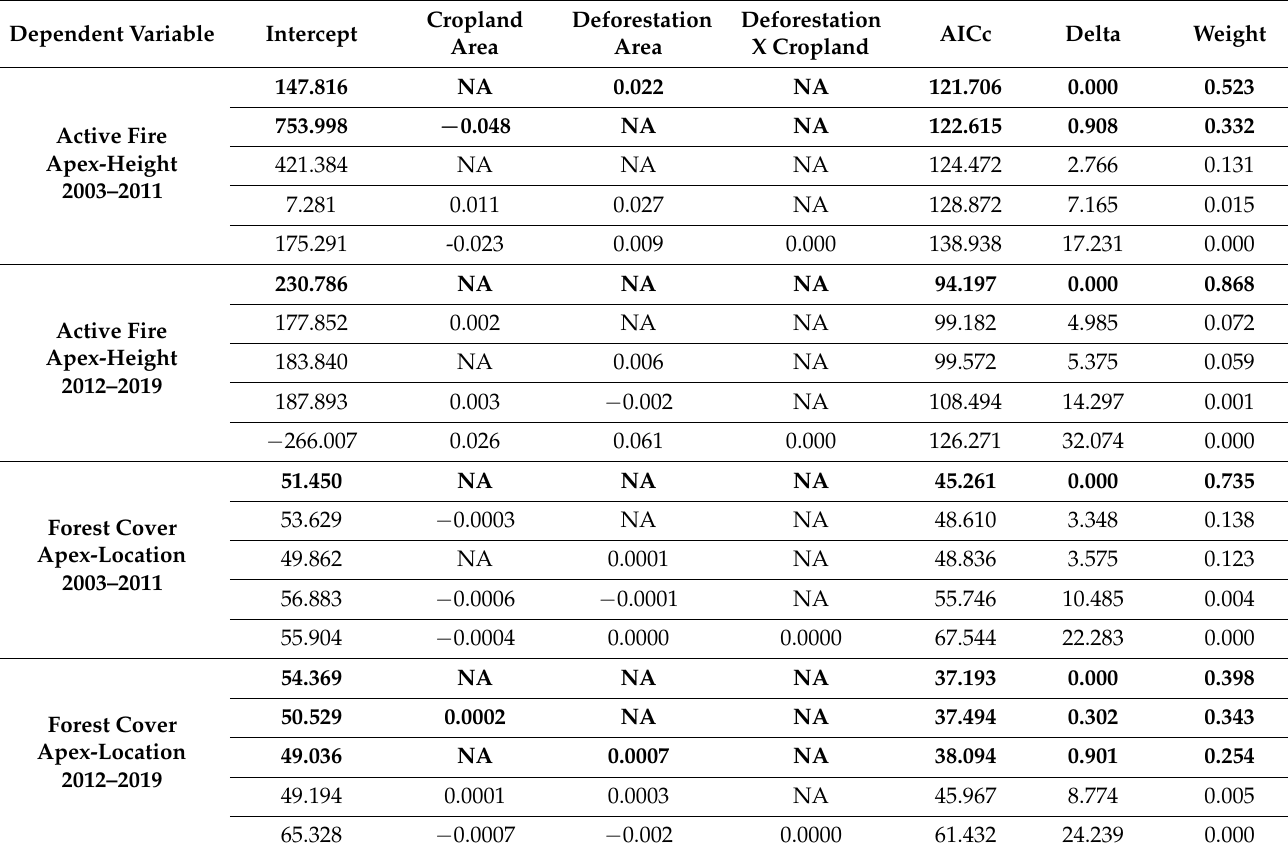
Table A4. Predicted models for the active fire apex-height and forest cover apex-location models for the two analyses periods: (i) 2003–2011 and (ii) 2012–2019. These analyses considered deforestation rates and cropland area as independent variables. The results are ranked by the AIC of each